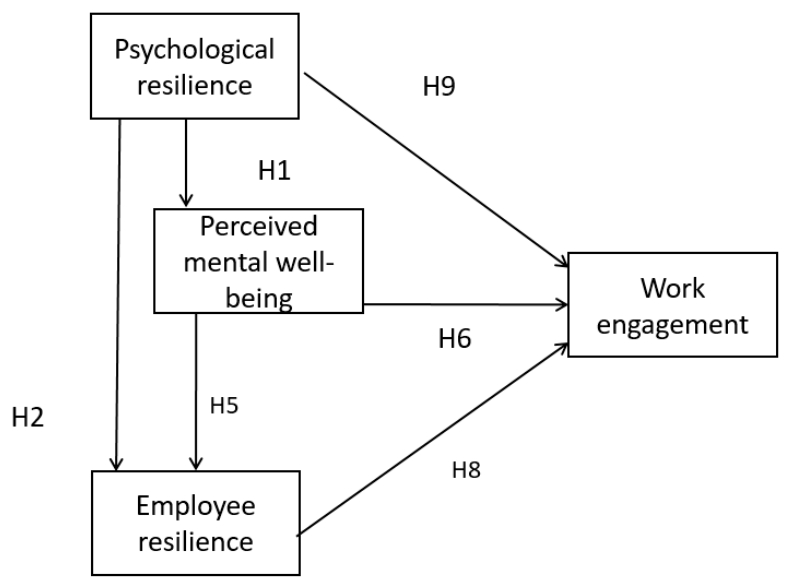
Figure 5. Complex mediation model.